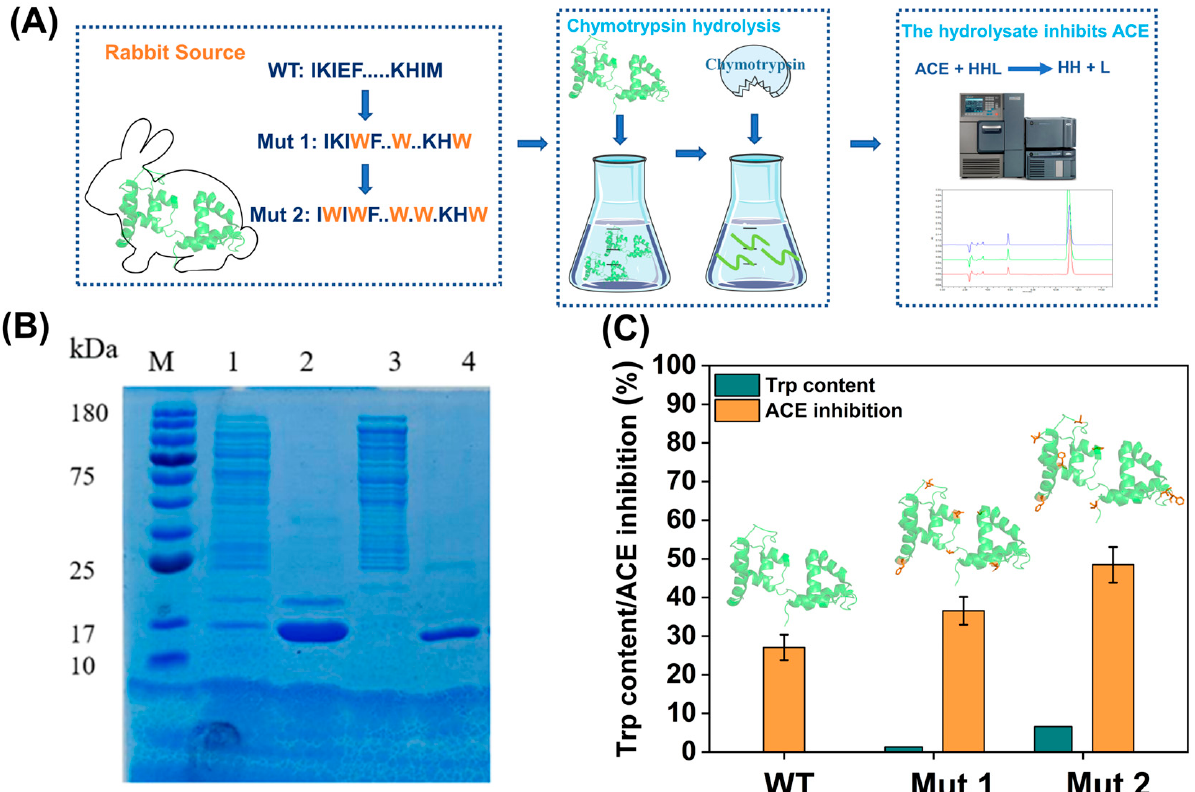
Figure 3. ( A ) Scheme of hydrolysis products inhibiting ACE activity. ( B ) Electrophoresis of purified proteins of mutants; 1–2: mut 1; 3–4: mut 2. ( C ) Effect of substrate Trp content on ACE inhibition